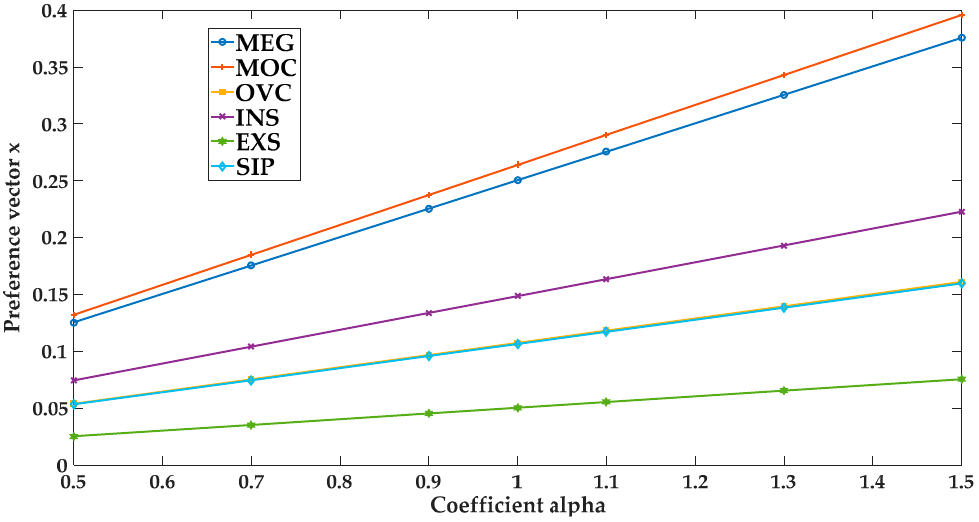
Figure 5. Graphical representation of the sensitivity analysis.